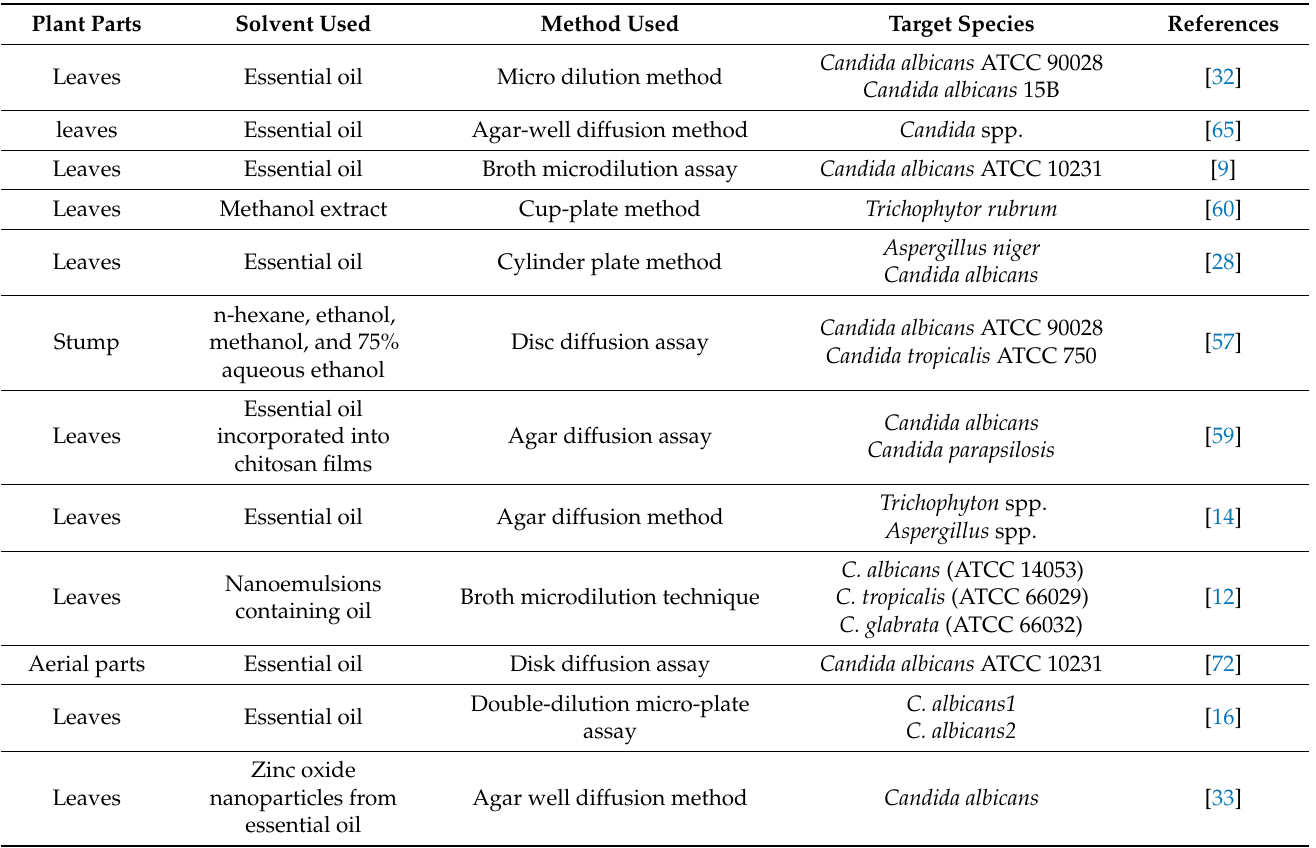
Table 3. Antifungal activities reported in different parts of E. globulus